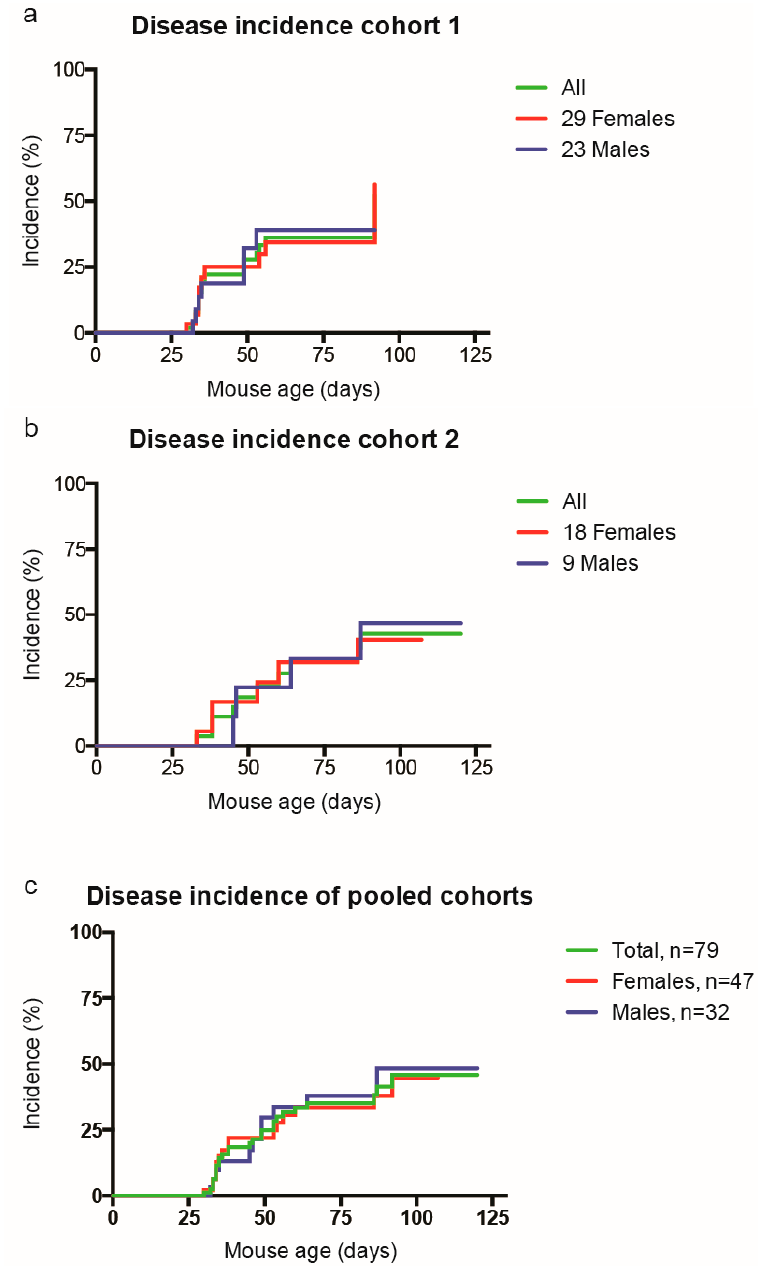
Figure 2. Early disease onset in the OSE mouse line precludes smoke exposure experiments. Onset of disease was monitored on two cohorts of OSE mice housed in separate breeding rooms. ( a ) Disease onset of cohort 1 monitored for up to 90 days postpartum ( n = 52; 29 females and 23 males). ( b ) Disease onset for cohort 2 monitored for up to 120 days ( n = 27; 18 females, 9 males). ( c ) Pooled data from the two cohorts. Disease incidence curves from the pooled data of the two cohorts were compared for males and females and showed no statistical difference (Logrank test) between sexes.